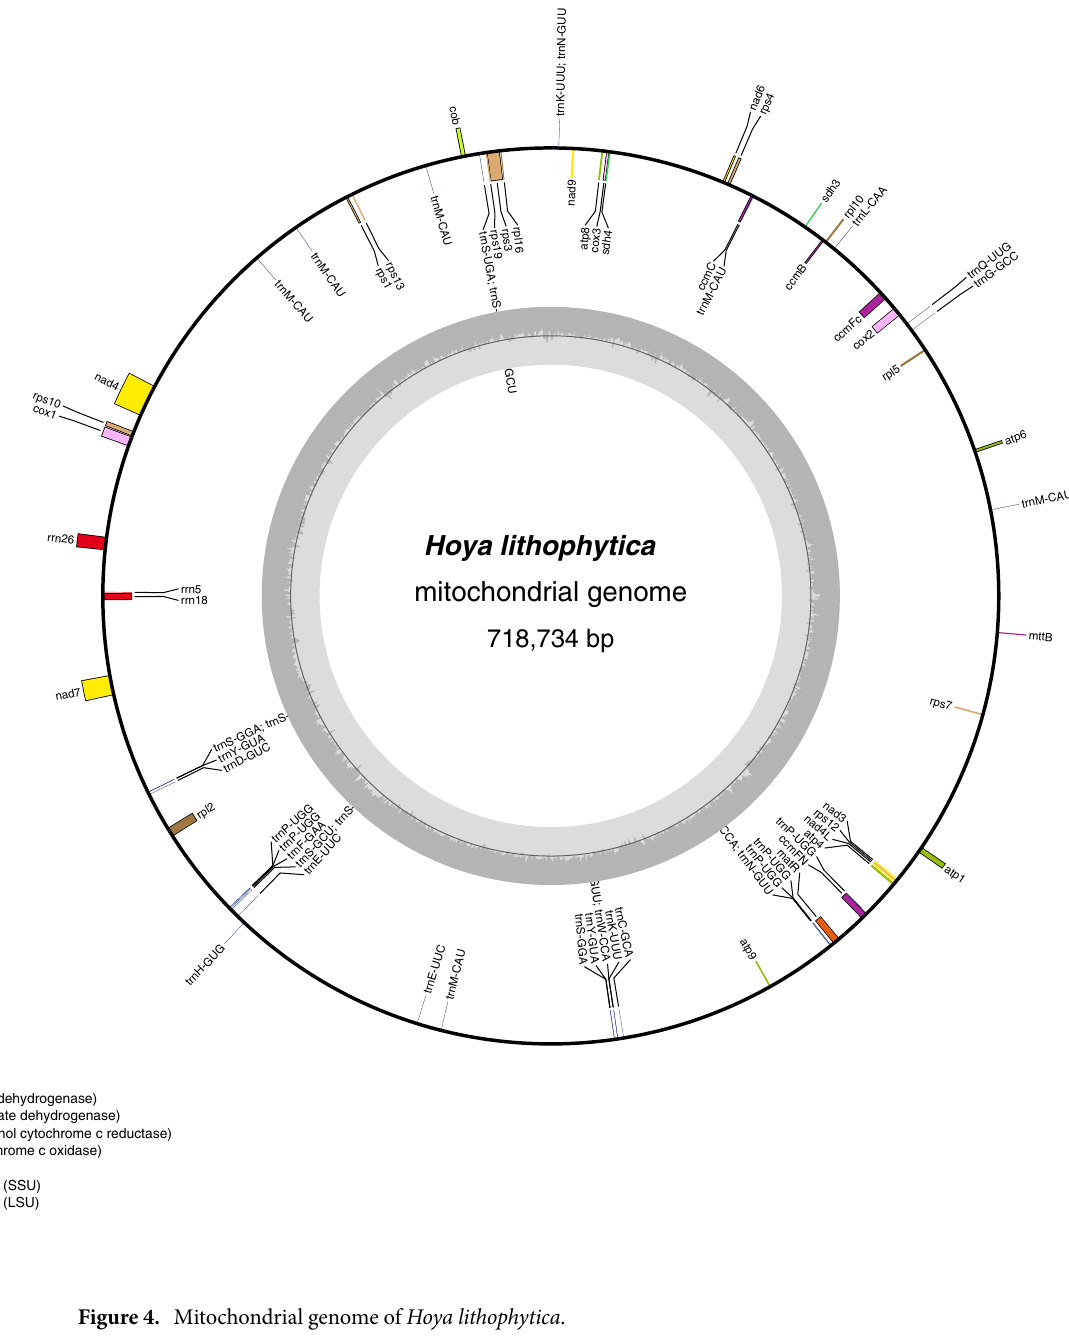
Figure 4. Mitochondrial genome of Hoya lithophytica